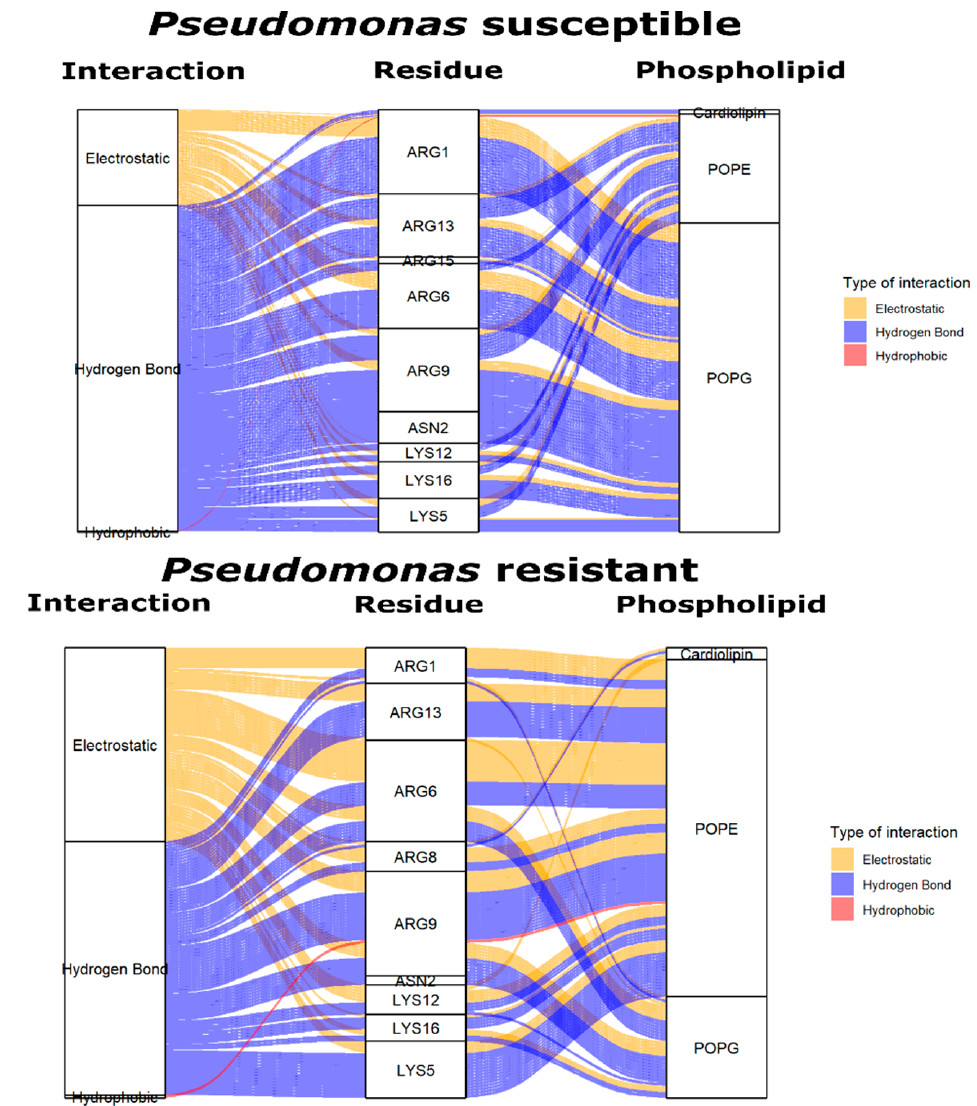
Figure 5. Type of intermolecular interaction with ∆ M2 residues and type of phospholipids with more interactions between the peptide and the two types of Pseudomonas membrane models (susceptible and resistant). Electrostatic interaction (yellow), hydrogen bond interaction (blue), and hydrophobic interaction (red). Phospholipids POPE (phosphatidylethanolamine), POPG (phosphatidylglycerol). The likelihood of intermolecular interactions with phospholipids is determined by the number and type of phospholipid. After 5 ns, for example, there were more hydrogen bond interactions than electrostatic ones (Figure 3). The phospholipid POPG is not the principal component of WTPa membranes; however, it has two − OH groups in the polar headgroup and is responsible for most of the H bonds (Figure 5). POPE, the most abundant phospholipid, has an amino group on the polar head that contributes additional linkages, but not as frequently as POPG. This may be due to the fact that the NH 3+ group of POPE binds with oxygen from unesterified phosphate by very close contacts [17], hindering the reorientation of the amino group towards the peptide. On the other hand, the PO 4 − group would be responsible for the electrostatic interactions, more frequently at 10 and 50 ns, in addition to additional H bonds [46]. It was revealed that the membrane model that simulates CRPa has a higher